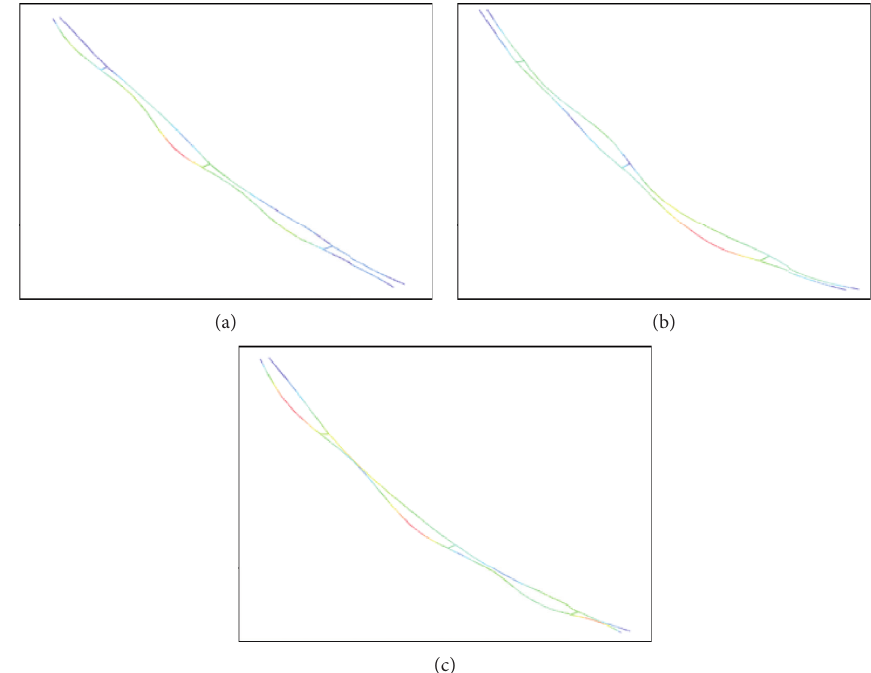
Figure 13: The typical motion state at a moment of an iced twin bundle conductor under different current intensities ( α � 30 ° ): (a) I � 0A, (b) I � 500A, and (c) I � 750A.